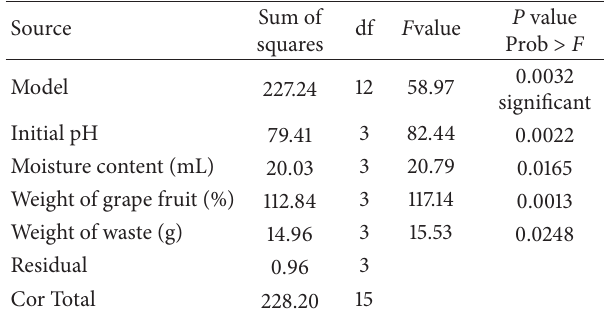
Table5:Statisticalanalysis(ANOVA)forevaluatingthesignificance of variables.